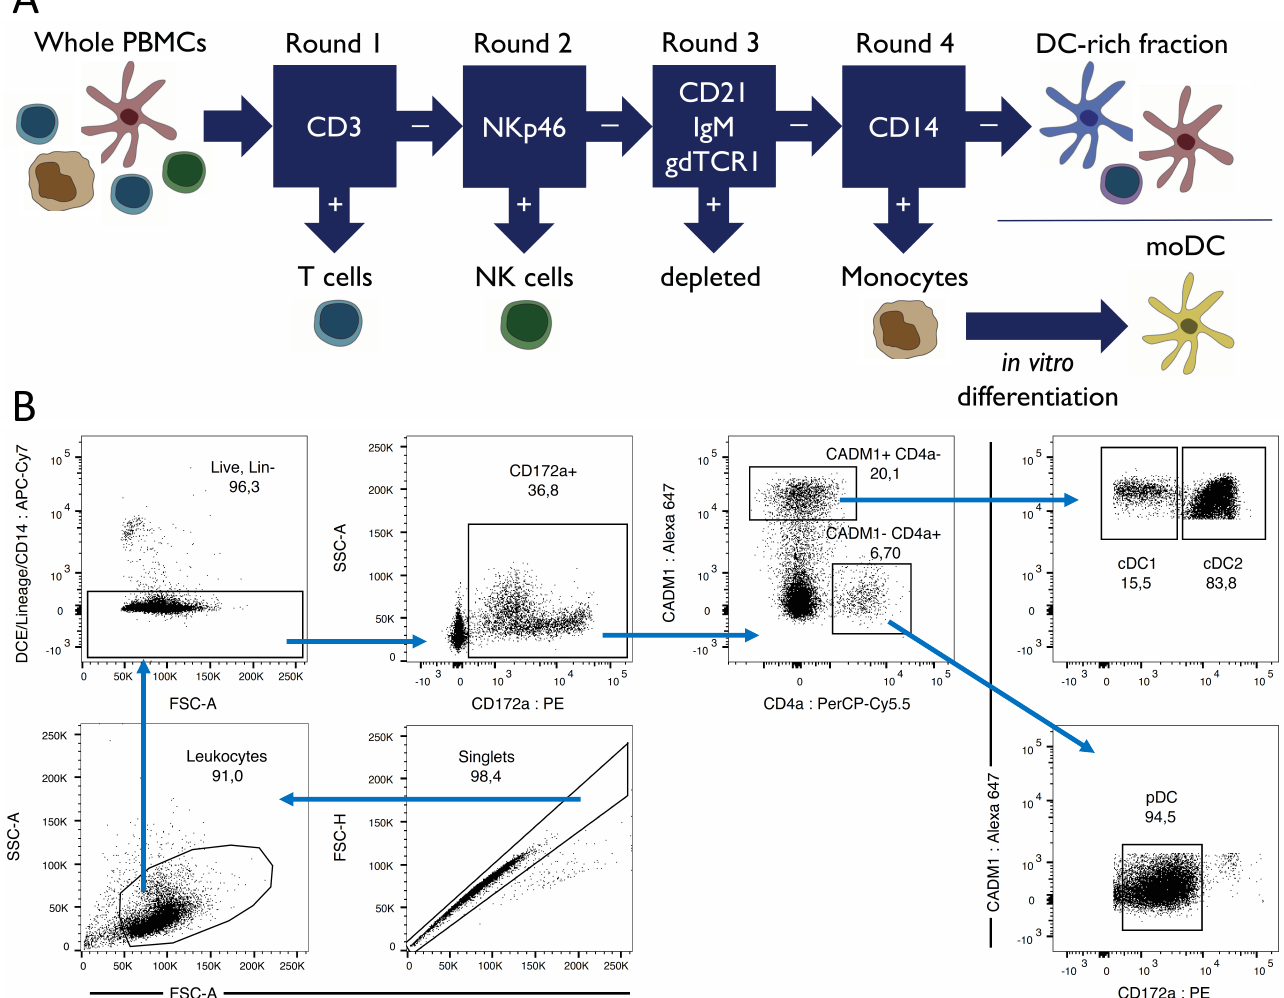
Figure 1. ( A ) Illustration of the magnetic-activated cell sorting (MACS) strategy used to isolate CD3+ T cells, CD3– NKp46+ cells, monocytes, and DC-enriched PBMCs. Consecutive rounds of sorting were performed to succes- sively sort CD3+ T cells, NKp46+ cells, and CD14+ monocytes, and to further deplete CD21+, IgM+, and gdTCR1+ cells in order to obtain a DC-enriched population. Monocytes were subsequently differentiated in vitro to generate monocyte- derived (mo)DC. ( B ) FACS-sorting strategy used to isolate bona fide DC subsets from DC-enriched PBMCs. Cell aggregates were first excluded based on FSC-A/FSC-H size ratio, and then larger, less-granular cells were selected based on FSC- A/SSC-A parameters. Dead cells and any CD3+, gdTCR1+, CD21+, IgM+, NKp46+, or CD14+ cells remaining after MACS were excluded. CD172a+ cells were selected, and this population was differentiated on the basis of CD4a and CADM1 expression. CADM1+ CD4a − and CADM1 − CD4a+ subpopulations were both selected and further segregated for CD172a expression. CADM1+ CD4a − CD172a low cells constitute cDC1, CADM1+ CD4a − CD172a high cells constitute cDC2, and CADM1 − CD4a+ CD172a mid cells are classified as pDC. FACS plots display forward and side-scatter values on a linear scale, while all fluorescent markers are displayed on a biexponential